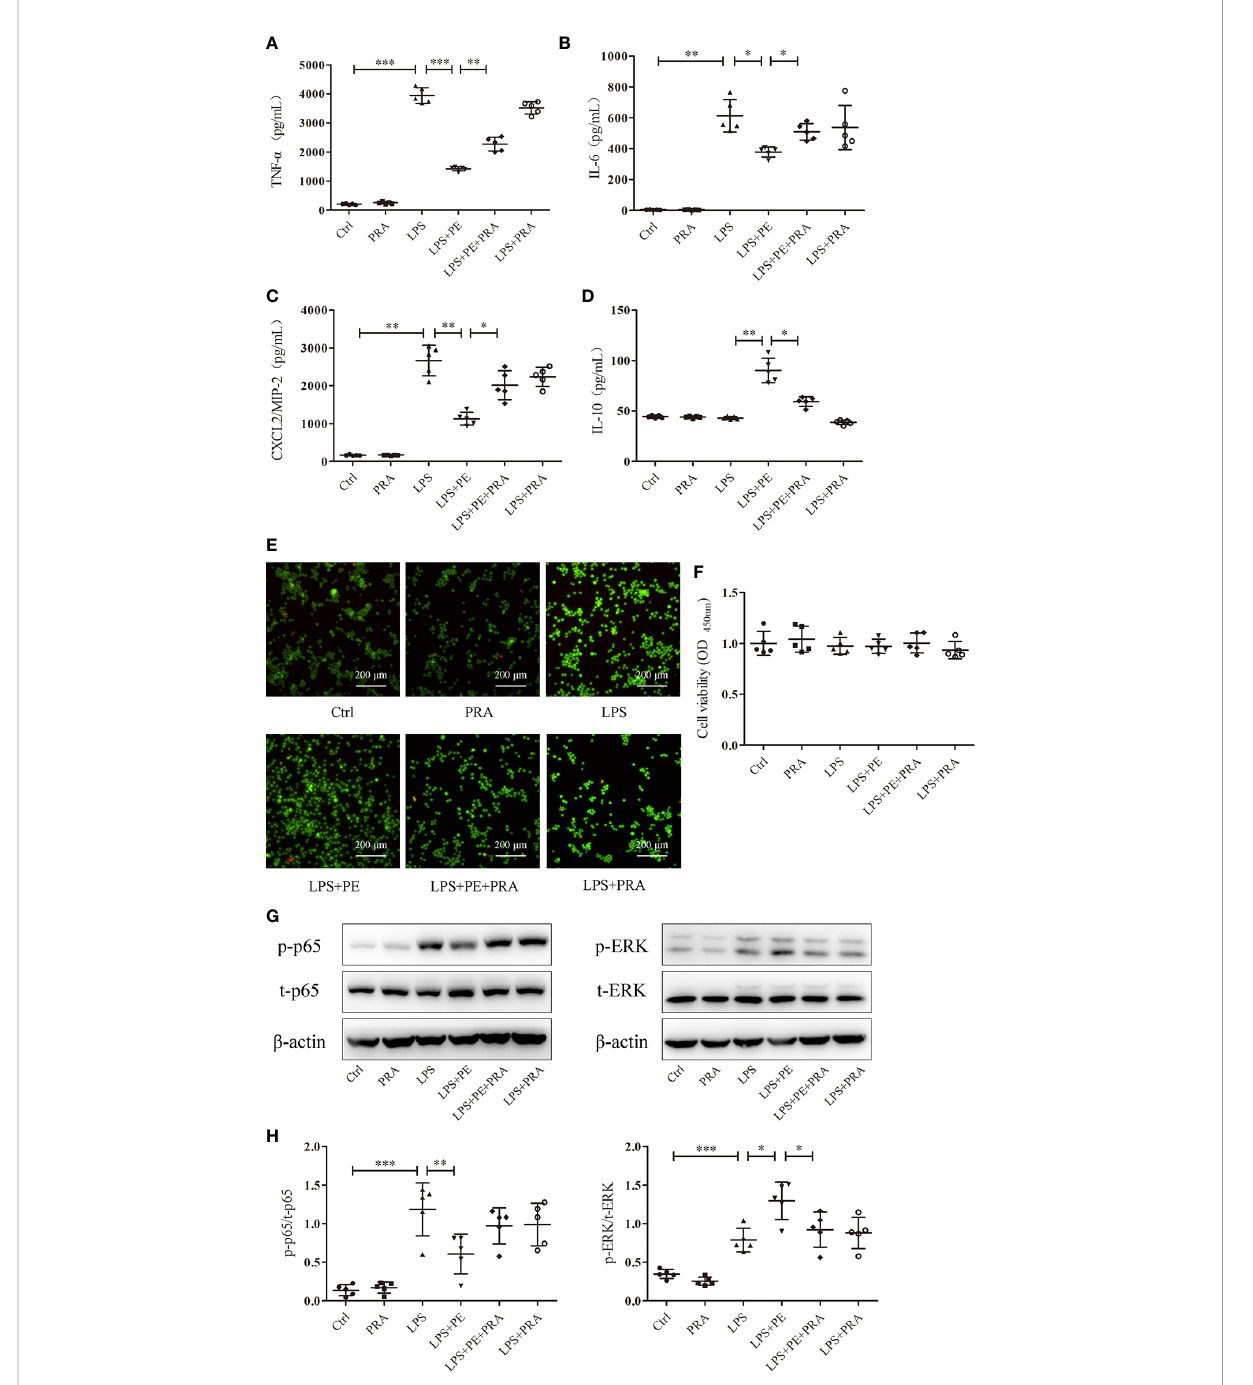
FIGURE 7 Prazosin (PRA) reversed the effect of phenylephrine (PE) on in fl ammation in lipopolysaccharide (LPS)-activated murine alveolar macrophages without in fl uencing cell viability by suppressing NF- k B activation and enhancing ERK1/2 activation. MH-S cells were incubated with PRA (10 -5 M) for 30 min, followed by PE (10 -5 M) treatment for 30 min, and then LPS (100 ng/mL) for 6 h Levels of TNF- a (A) , IL-6 (B) , CXCL2/MIP-2 (C) , and IL-10 (D) released from MH-S cells. (E) Live and dead cells were stained by calcein-AM and propidium iodide, respectively. Scale bar = 200 m M. (F) Cell viability was measured by CCK-8 assay. (G) Western blotting was used to evaluate activation of p65 and ERK1/2. (H) Phosphorylation of p65 and ERK1/2 were analysed according to grey values. Data are represented as the mean ± SD, n = 5 per group. * p < 0.05, ** p < 0.01, *** p <